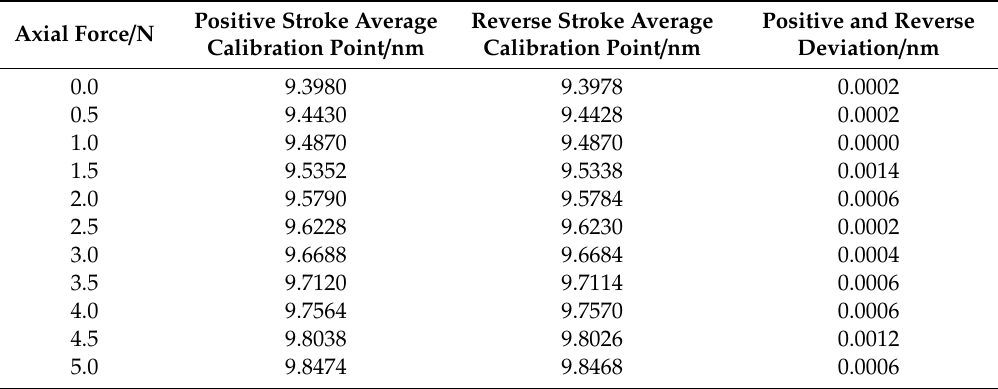
Table 5. The average calibration points and deviation values of axial force